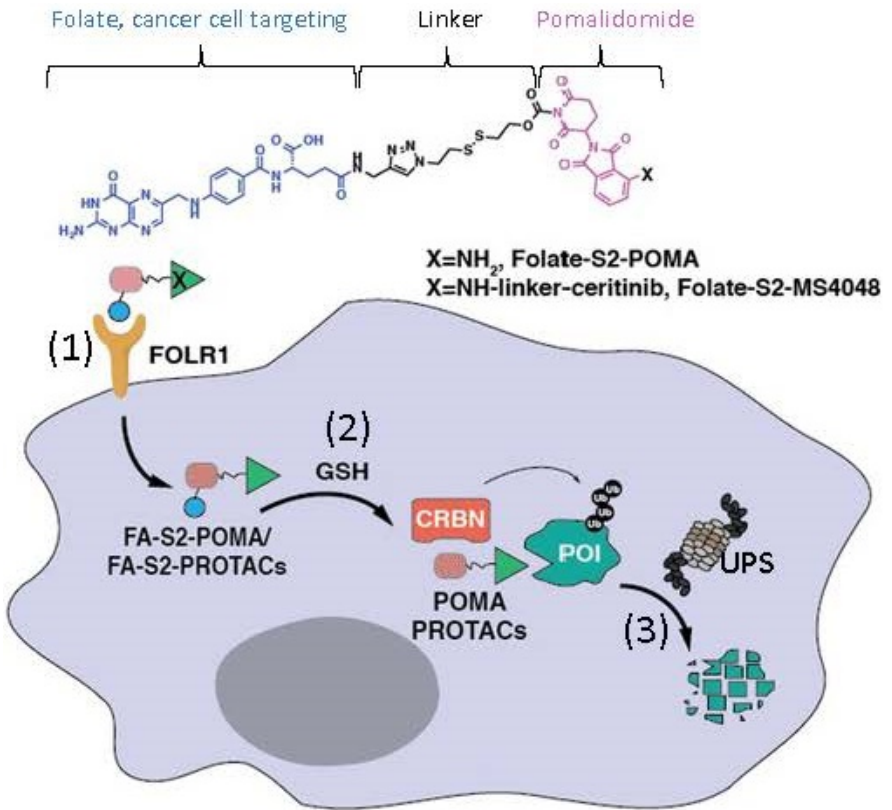
Figure 2. This diagram shows the mode of action of folate–pomalidomide and folate-conjugated pomalidomide-based PROTACs. Upon binding FOLR1 on the cell membrane (1), folate-pomalidomide or folate-conjugated IMiD-based PROTACs are transported into cells, and the active pomalidomide or PROTACs are released after the reduction by endogenous GSH (2). The active pomalidomide or PROTACs recruit endogenous CRBN E3 ligase (similar to the model shown in Figure 1B), leading to polyubiquitination and subsequent degradation of the glued proteins of interest (POIs, neosubstrates) by the UPS (3). This figure is adapted from an original paper by Chen et al. [14]. Human DDB1 and Cullin 4-associated factor 15 (DCAF15) protein is encoded by the DCAF15 gene, and a recent study revealed that genetic disruption of DCAF15 strongly sensitized cancer cells to natural killer (NK)-mediated clearance [15]. Similar to the case of the CRL4 CRBN complex E3 ligase in which CRBN acts as a substrate receptor of CRL4, DCAF15 can also be a part of the CRL4 complex E3 ligase, acting as the CRL4 E3 ligase complex’s substrate receptor/adaptor to be glued on protein neosubstrates, RBM39 and/or RBM23 through the MG compounds, aryl sulfonamides (e.g., indisulam, E7820,